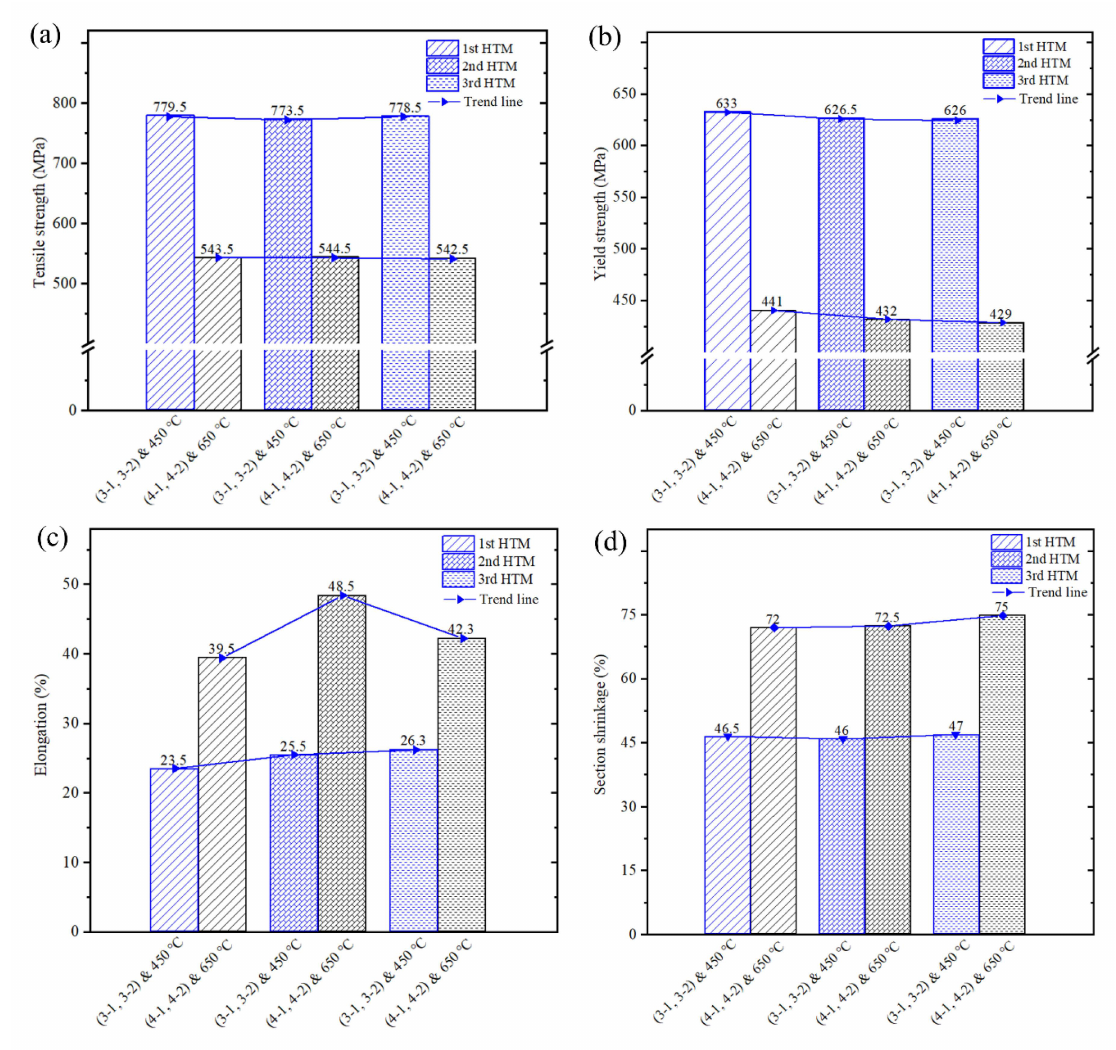
Figure 18. Mechanical properties of tensile specimens at high temperature: ( a ) the tensile strength, ( b ) the yield strength, ( c ) the elongation, and ( d ) the section